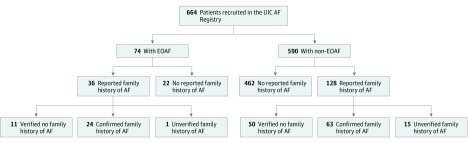
Flowchart Describing the University of Illinois at Chicago (UIC) Atrial Fibrillation (AF) RegistryThe chart shows the number of patients with early-onset AF (EOAF) and non–early-onset AF (non-EOAF), those reporting a family history of AF, and those in whom the family history was confirmed by electrocardiogram or medical record review.